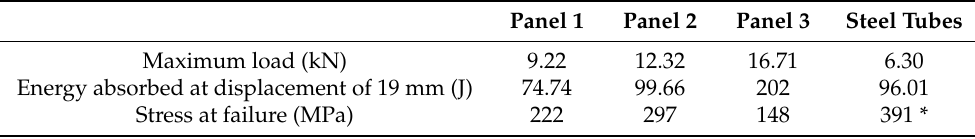
Figure 4. Three-point bending test results: Force as a function of displacement. Table 3. Results of three-point bending